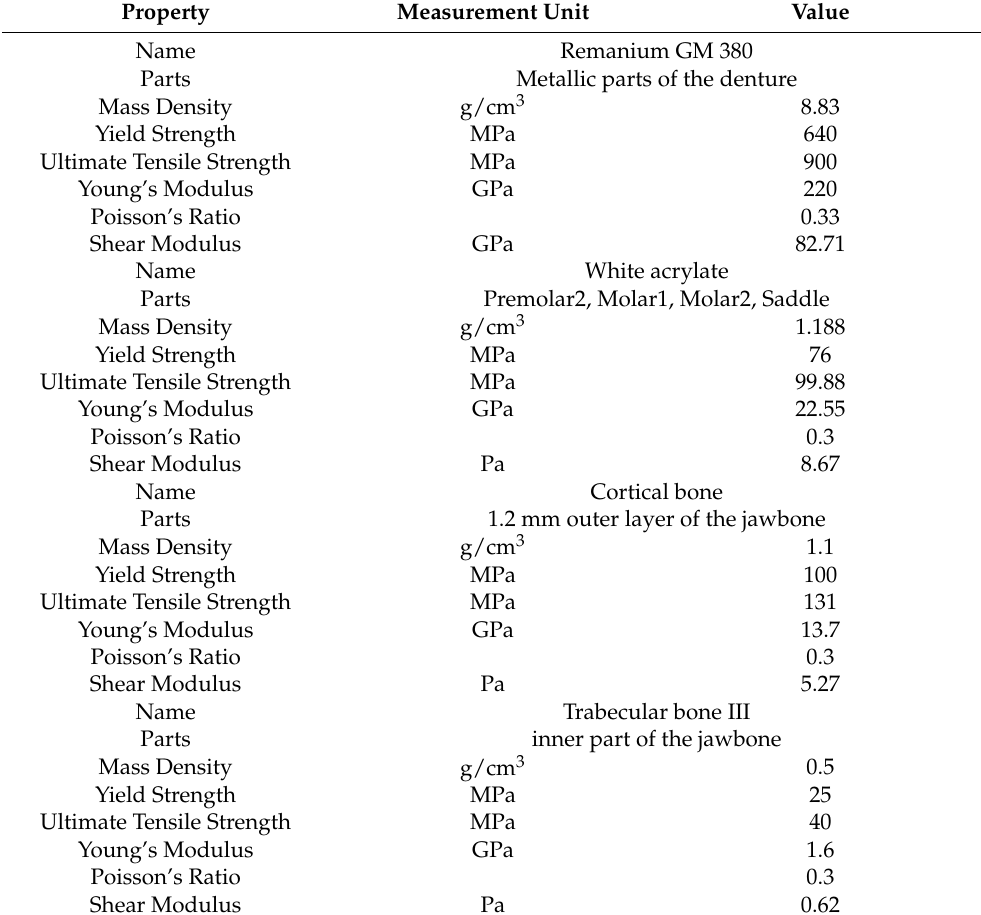
Table 2. The constant mechanical properties of the used